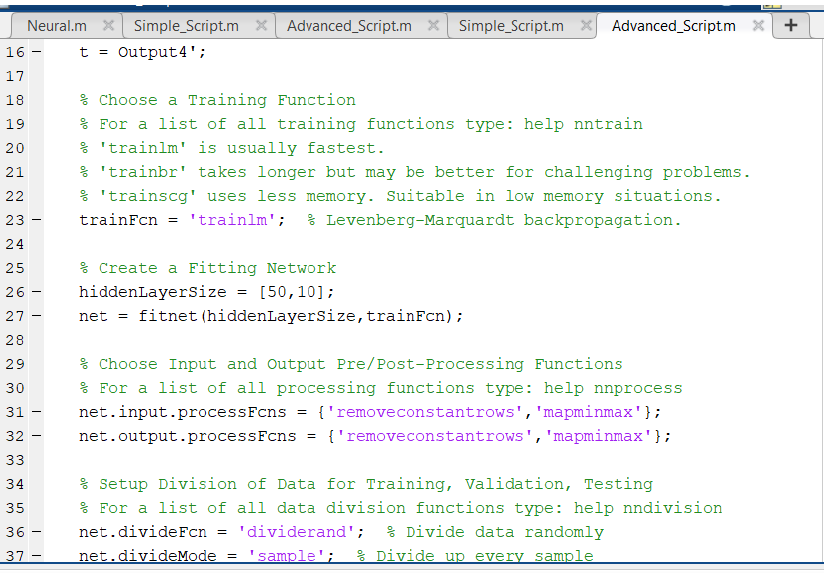
Figure 8. Addition of hidden layer.